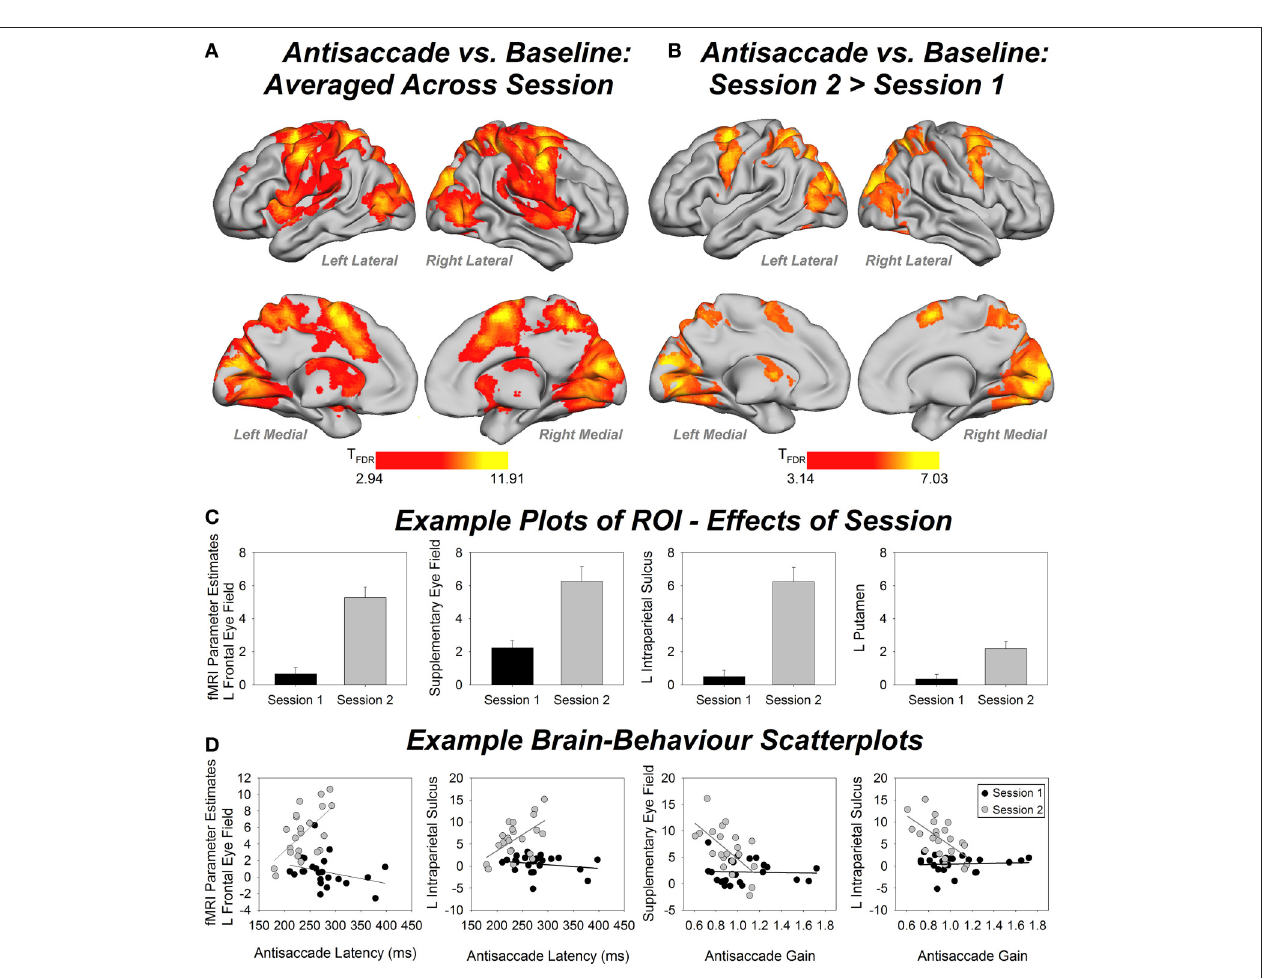
FIGURE 4 | (A) Whole-brain fMRI activity for the antisaccade vs. baseline condition, averaged over session. Contrast thresholded at FDR corrected p < 0.01 , extent threshold p < 0.05 . (B) Whole-brain fMRI activity for antisaccade session 2 > session 1. Contrast thresholded at FDR corrected p < 0.01 , extent threshold p < 0.05 . (C) Example bar plots for effects of session (fMRI parameter estimates) in four regions of interest (ROIs). Error bars show standard error. (D) Example scatterplots for brain-behavior correlations for session 1 (black) and session 2 (white). Y-axis shows fMRI parameter estimates. L, left.